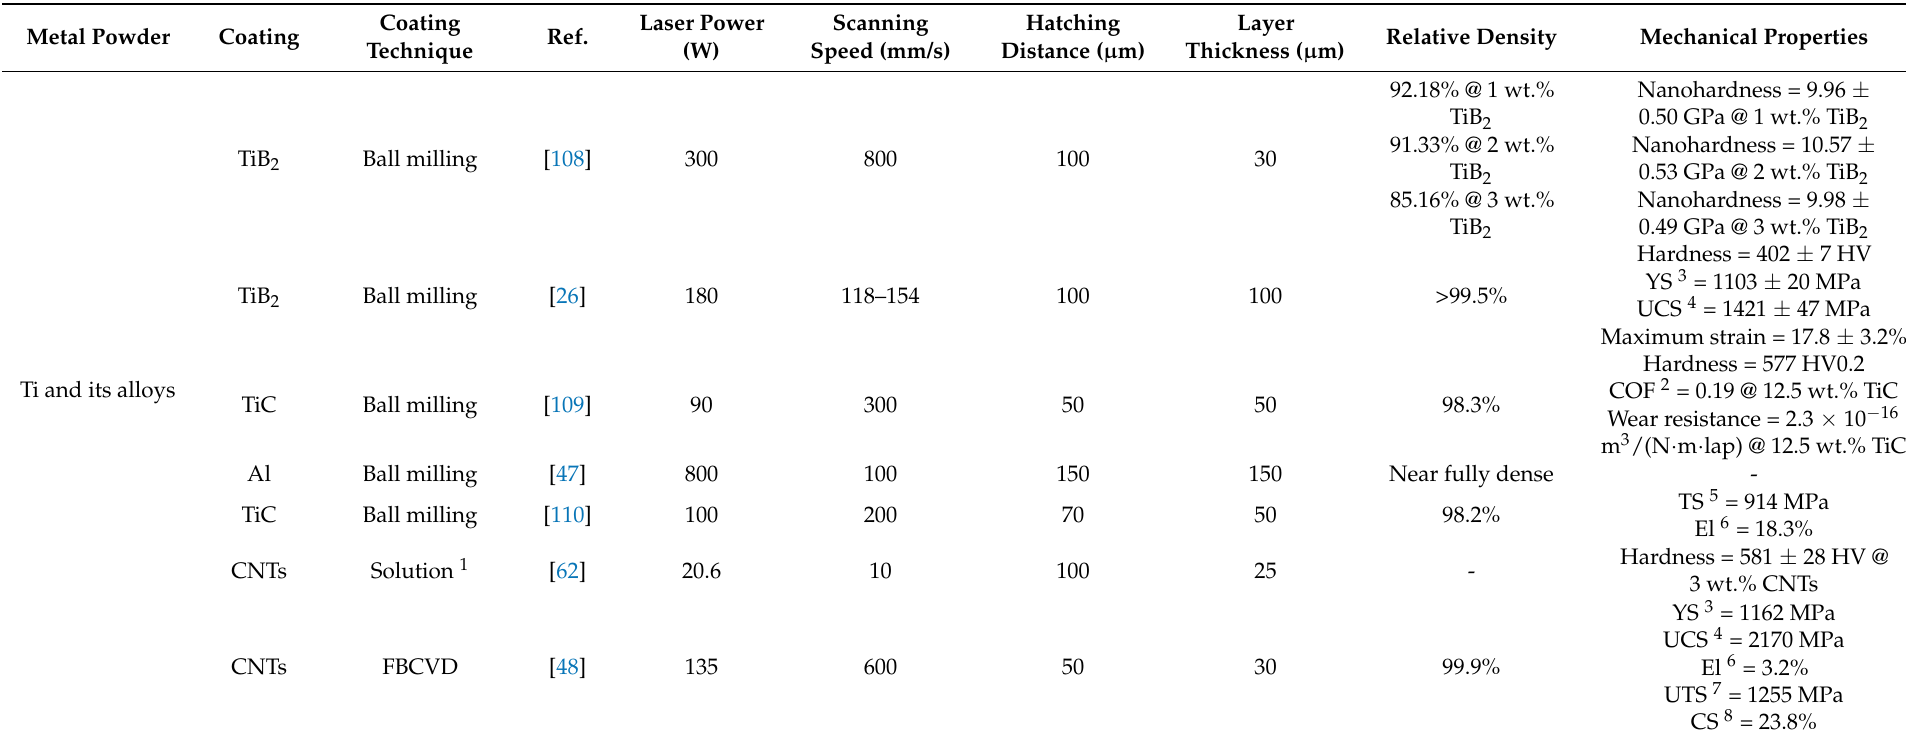
Table 3. A summary table reporting L-PBF process parameters, relative density and mechanical properties of printed parts using Ti-based alloys. Metal